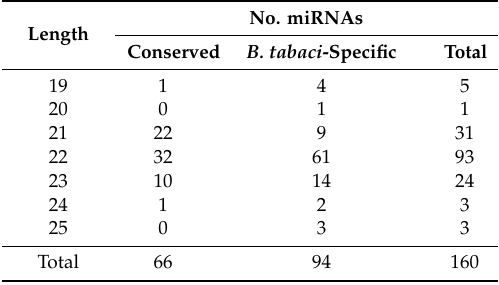
Table 1. Number of conserved and B. tabaci -specific microRNAs identified in this study. No. miRNAs Length